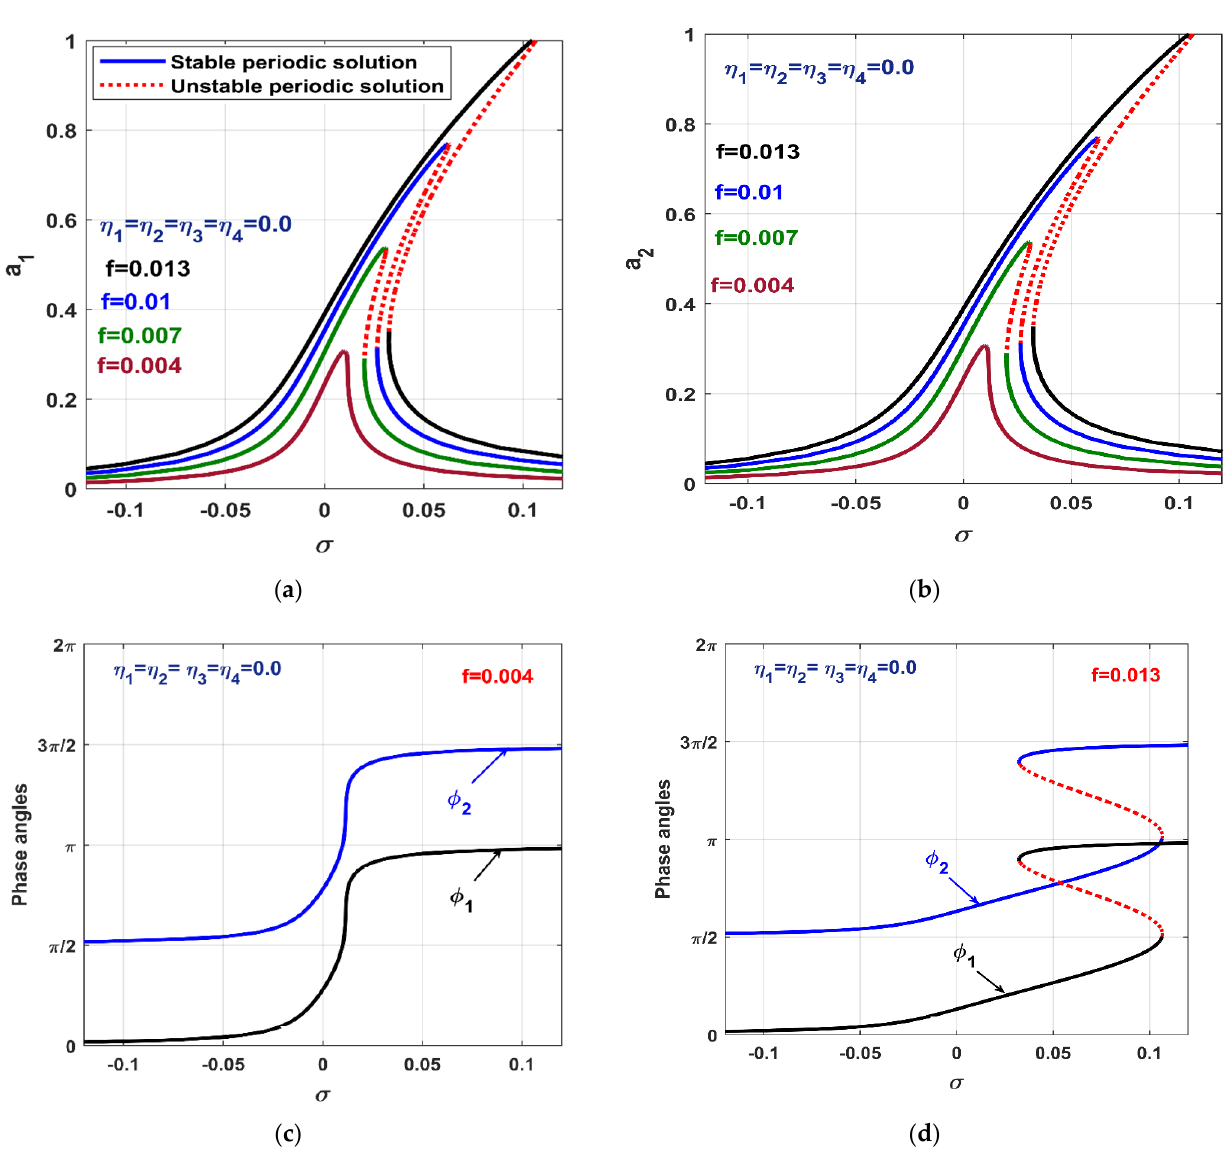
Figure 3. Vibration amplitudes and phase angles of the twelve-poles rotor in the case of the PD - control algorithm only: ( a , b ) vibration amplitudes ( a 1 , a 2 ) when f = 0.004, 0.007, 0.01, and 0.013, ( c ) phase angles ( φ 1 , φ 2 ) when f = 0.004, ( d ) phase angles ( φ 1 , φ 2 ) when f =